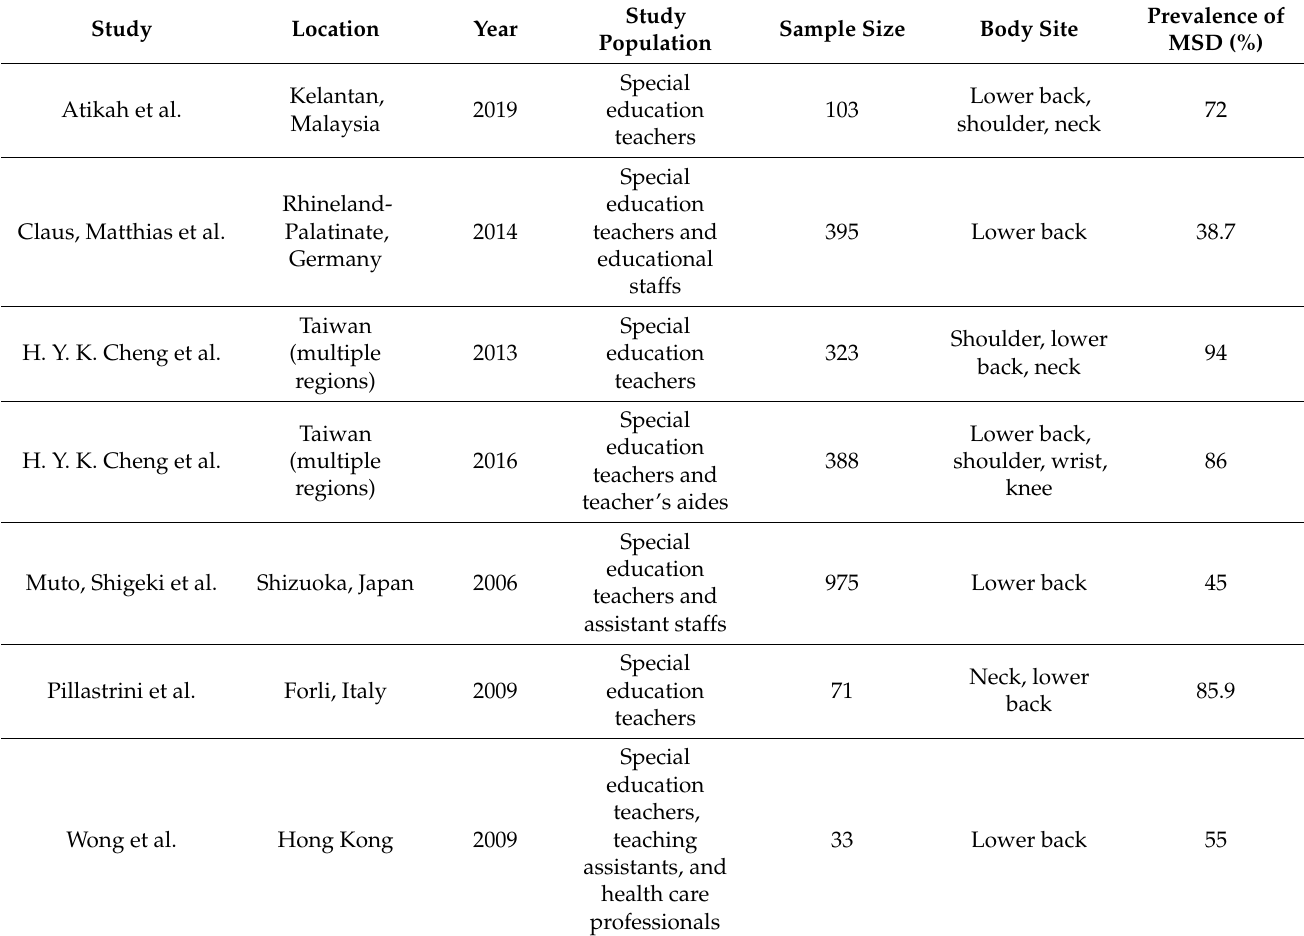
Table 2. Studies reporting the prevalence of MSD among special education school